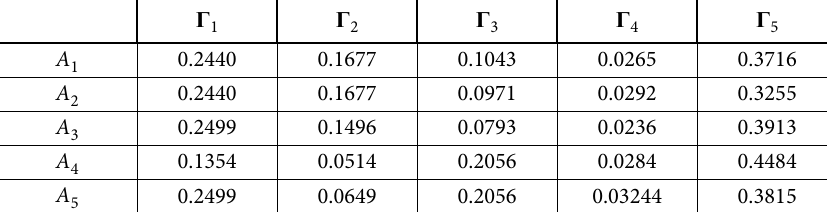
Table 13. The probability weight for every